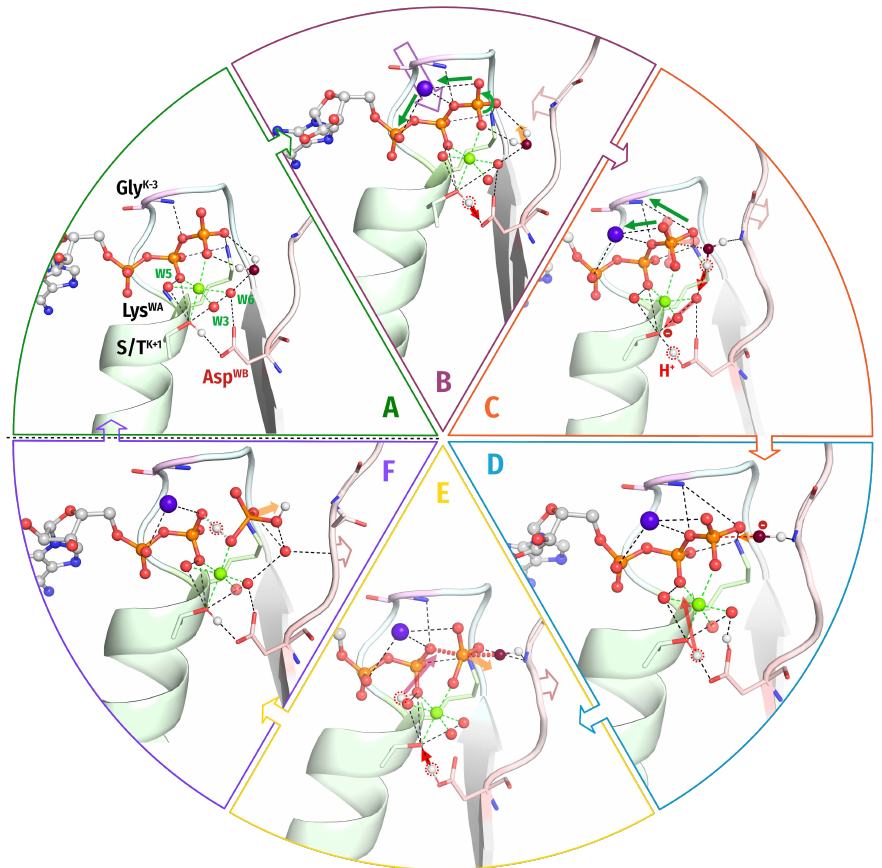
Figure 12. Common scheme of stimulated hydrolysis in P-loop NTPases. Empty purple arrow, insertion of the stimulator (shown as a purple sphere); pink arrows, movements of the WB-crest; green arrows, rotation and planarization of γ -phosphate; red arrows, proton displacements; orange arrows, detachment of Pi. The following crystal structures were used as templates: panels ( A , B )—PDB